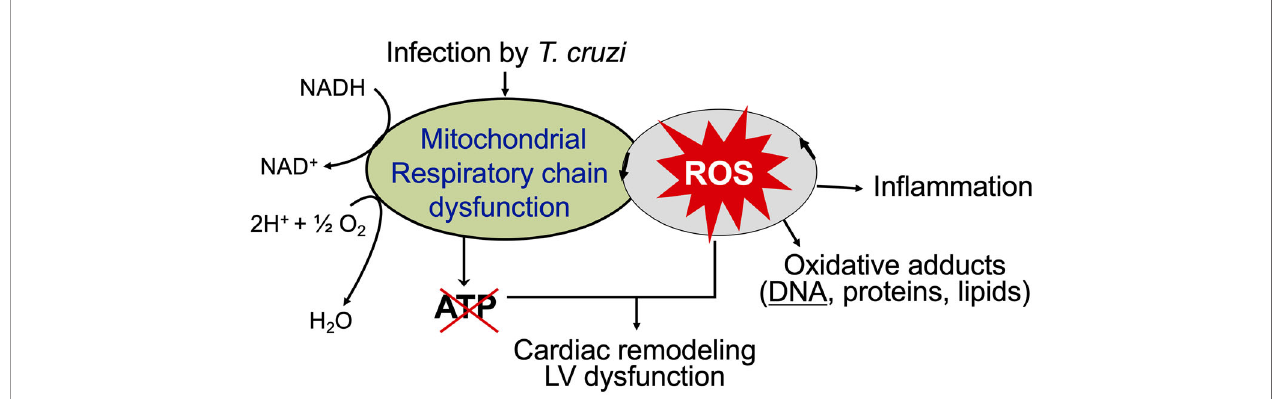
FIGURE 3 | Mitochondrial ROS contribute to cardiac damage, in fl ammation, and remodeling in chronic Chagas cardiomyopathy. Mitochondrial dysfunction of electron transport chain is sustained in chronically infected mice and humans that results in persistence of ROS production and a decline in oxidative phosphorylation and ATP production. ROS-induced oxidative adducts signal in fl ammatory responses. Antioxidants capable of scavenging ROS have a potential to control cardiac damage and remodeling in chronic